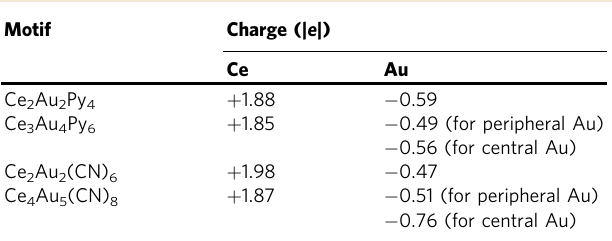
Table 1 Bader charges of the Ce – Au clusters in the coordination